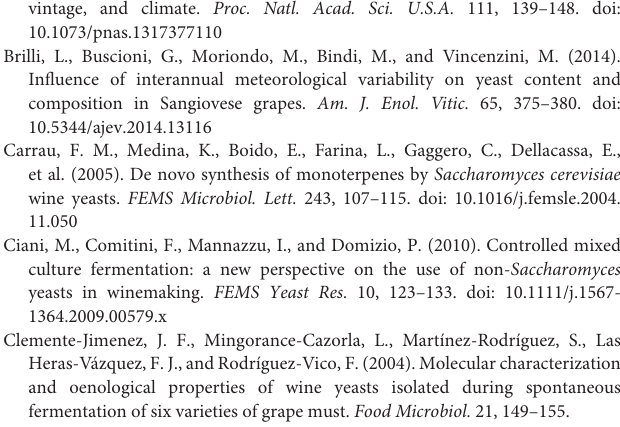
FIGURE S1 | Phylogenetic analysis of Chilean of Metschnikowia using D1/D2 domain. Two sequences from GenBank were included as reference (KM249369 and KM658981). FIGURE S2 | Phylogenetic analysis of Chilean isolates of using D1/D2 domain for Hanseniaspora and Rhodotorula